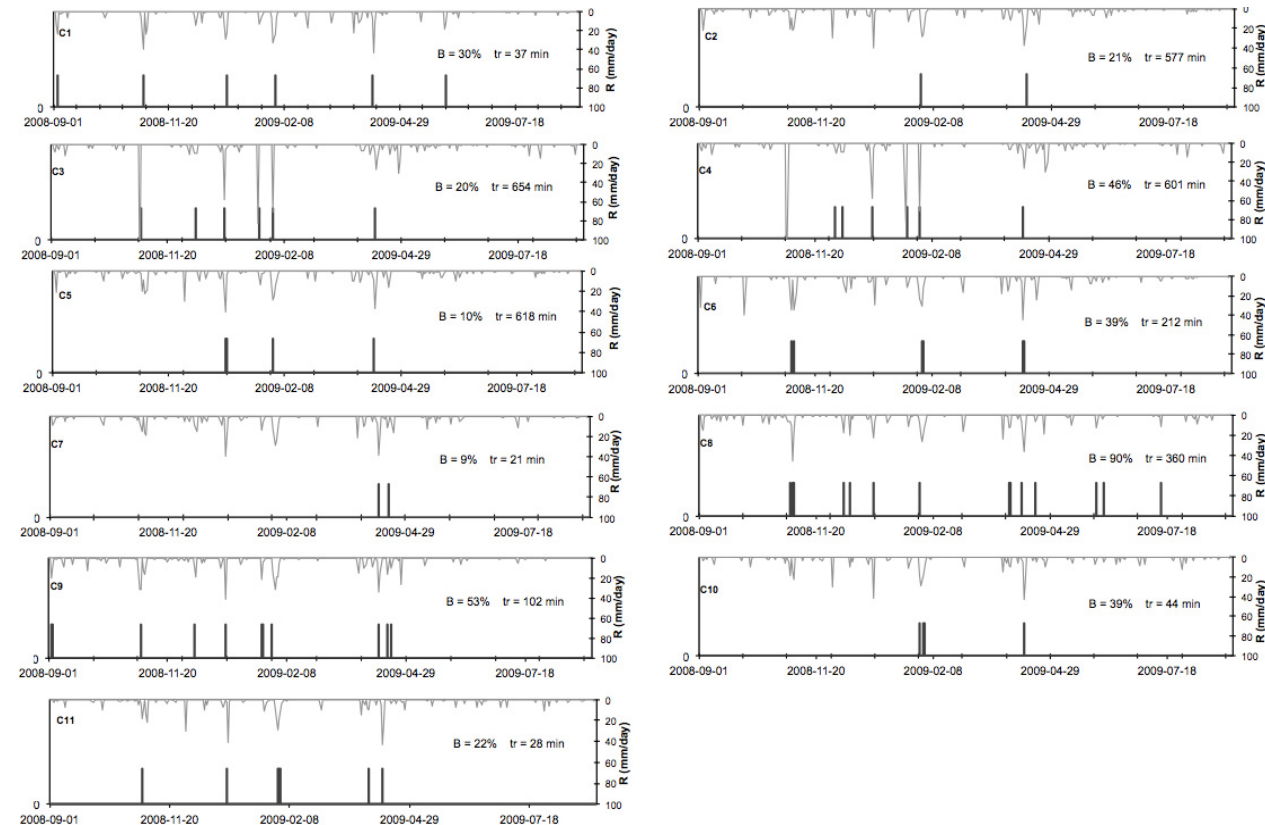
Figure 10. Annual stream flow time series. B is the frequency of occurrence of a runoff event and tr denotes the mean rising times, both indicators are calculated for the eleven